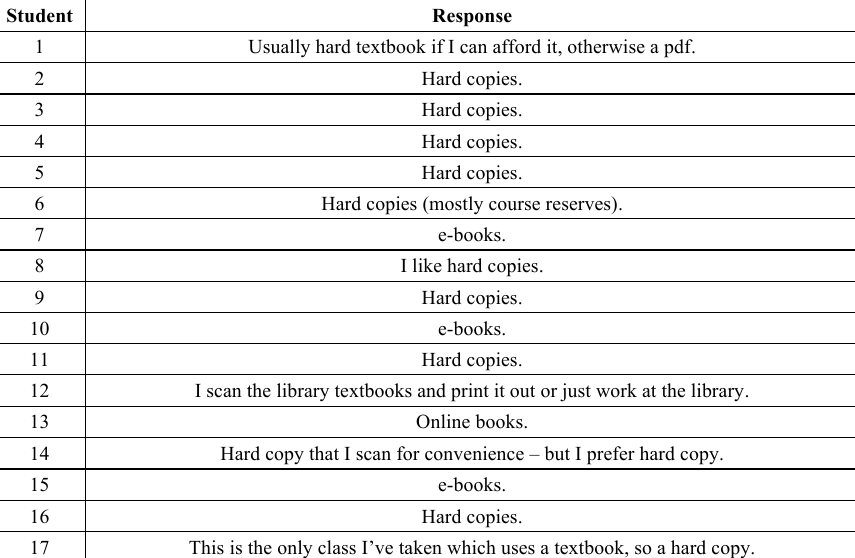
Table 1. Question 1 : What form of textbook do you use in your